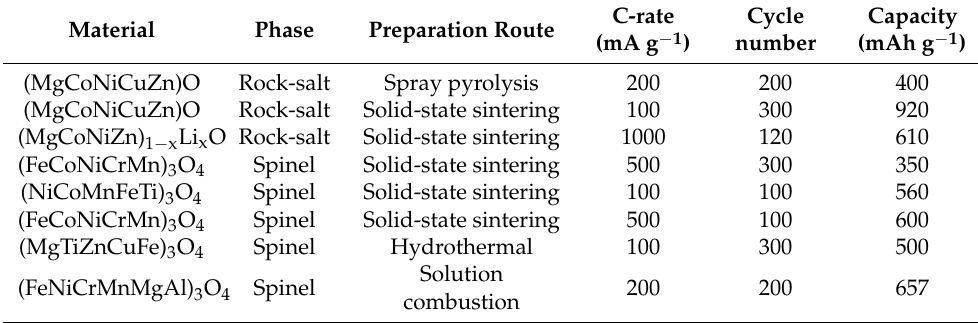
Table 1. Electrochemical performances of recently reported high entropy oxide